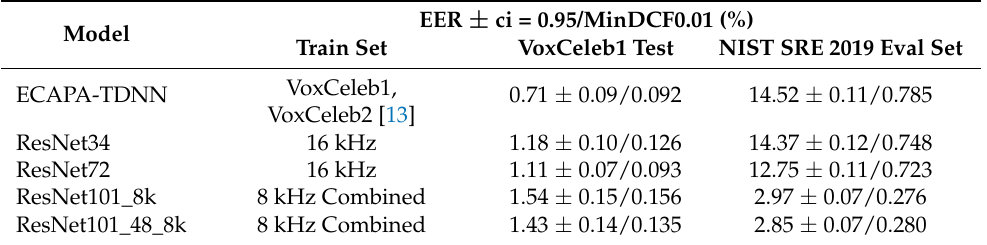
Table 2. Results of speaker verification systems for the in-domain Voxceleb1 test and the out-of- domain NIST SRE 2019 eval sets in terms of the EER ± 95% confidence interval/minDCF (%). Lower error values are better.